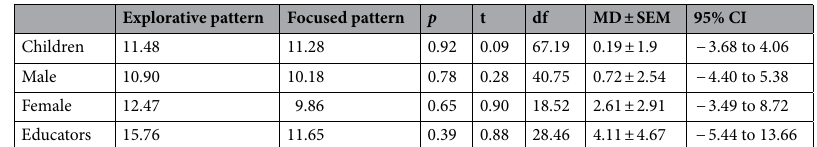
Table 2. Shows the children and their educators mean pupil diameter increase (%) when they viewed images of a midline diastema and without diastema. T-test with significance at p < 0.05. p = p -value, t = t-value, df = Degrees of freedom, MD = Mean difference, SEM = Standard error of mean, 95% CI = 95% confidence